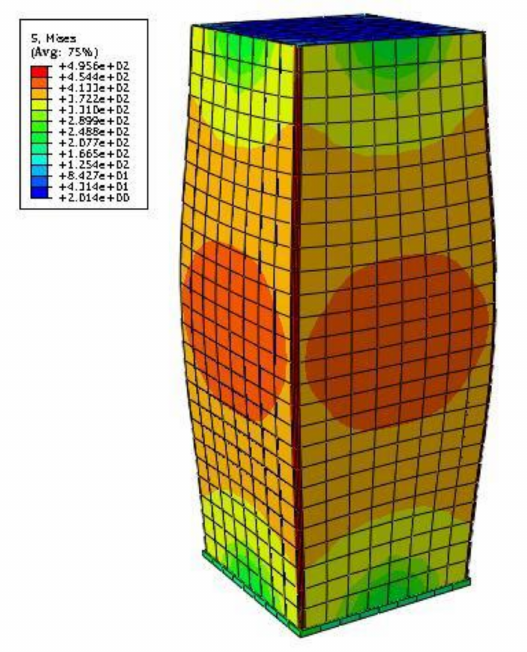
Figure 4. FE stress nephogram of CFCFST stub column at ultimate limit